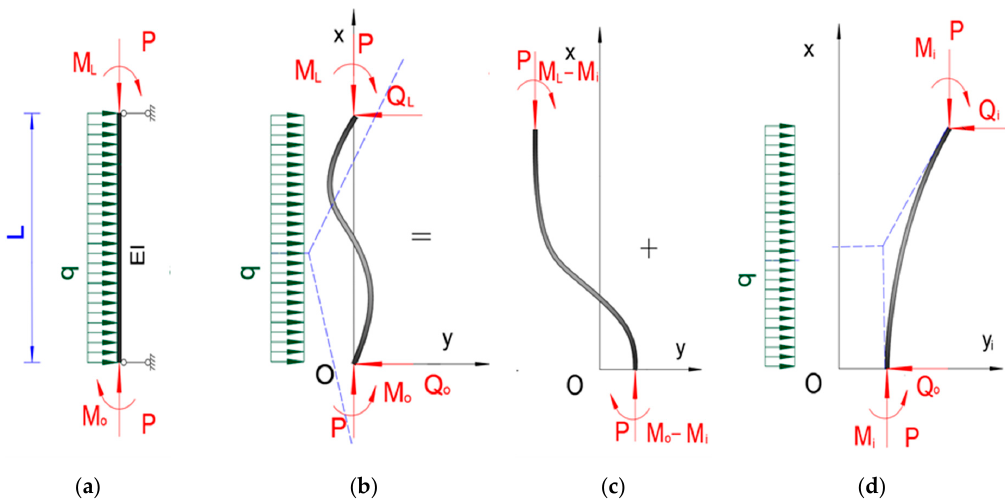
Figure 6. Decomposition diagram of the deflection curve of simply supported compression rods: ( a ) compression rod force diagram; ( b ) bending equilibrium deflection curve of rods; ( c ) sine curve decomposed by the deflection curve; and ( d ) quadratic parabola decomposed by the deflection curve.